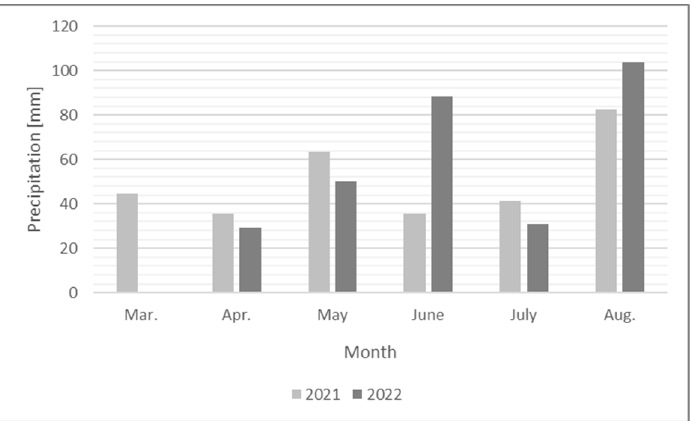
Figure 4. Average amount of precipitation [mm] during the growing seasons.